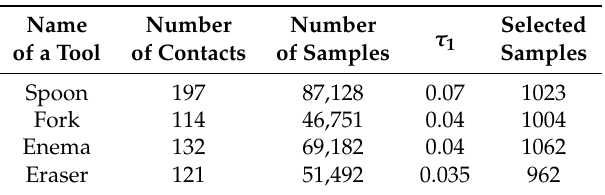
Table 1. The number of samples that were collected and used in the test. Second and third columns represent the number of palpations and collected samples per each dataset. The last column shows the average number of samples in a subset for the 10-fold cross-validation. The value of τ 1 is a threshold used in SMASS algorithm. Name of a